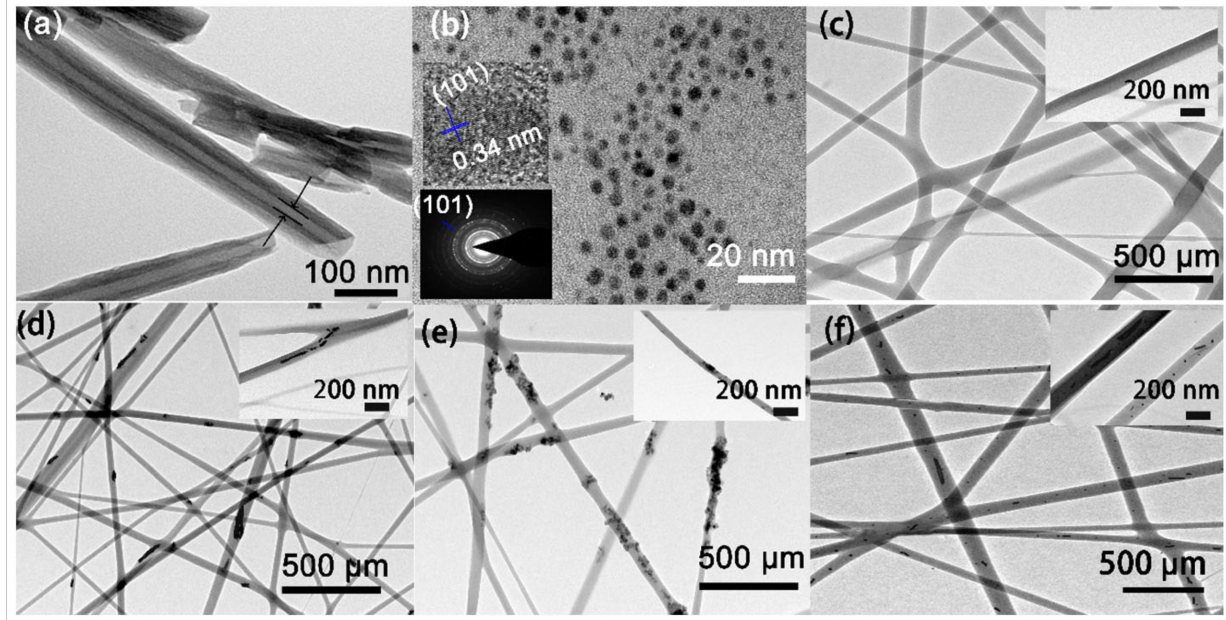
Figure 10. TEM images of ( a ) HNTs, ( b ) Fe 3 O 4 nanoparticles (insets are the selected area electron diffraction pattern and HRTEM image), ( c ) PEO/CS nanofibers, ( d ) Fe 3 O 4 /PEO/CS nanofibers (4% Fe 3 O 4 ), ( e ) HNT/PEO/CS nanofibers (4% HNTs), and ( f ) HNT/Fe 3 O 4 /PEO/CS nanofibers (4% Fe 3 O 4 and 4% HNT). Reprinted with permission from Ref. [90], Elsevier